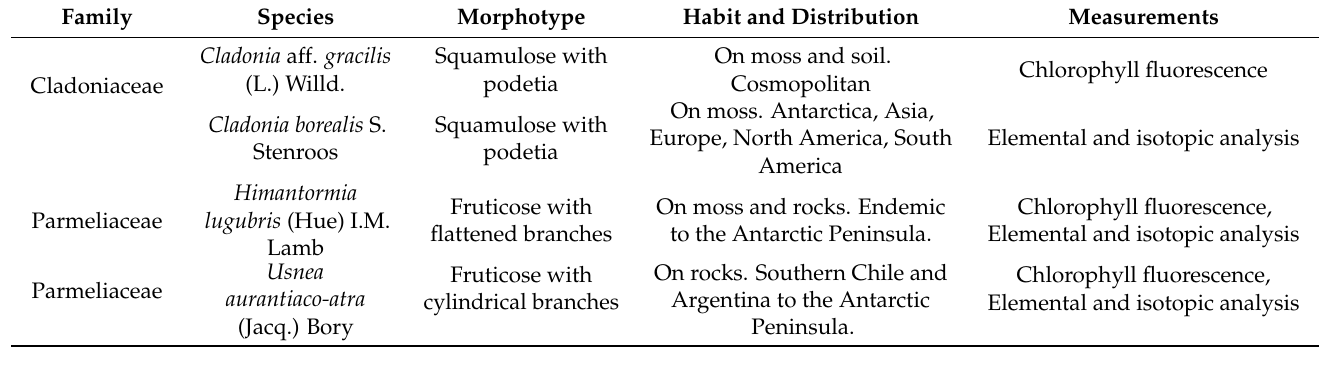
Table 3. Chlorolichen species used in the experimentation with desiccation and thermal shock kinetics, with their respective morphotype, habits, and distribution and the measurements performed.